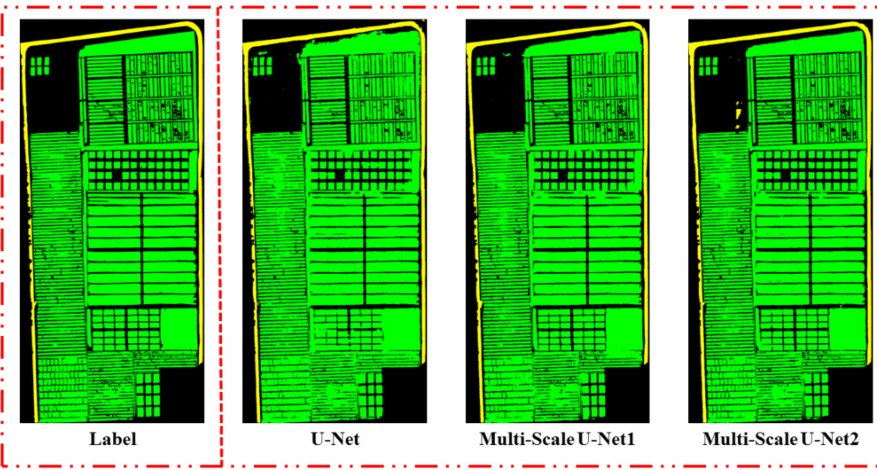
Figure 19. Three network models predict the results (GSD: 6.89 cm × 6.89